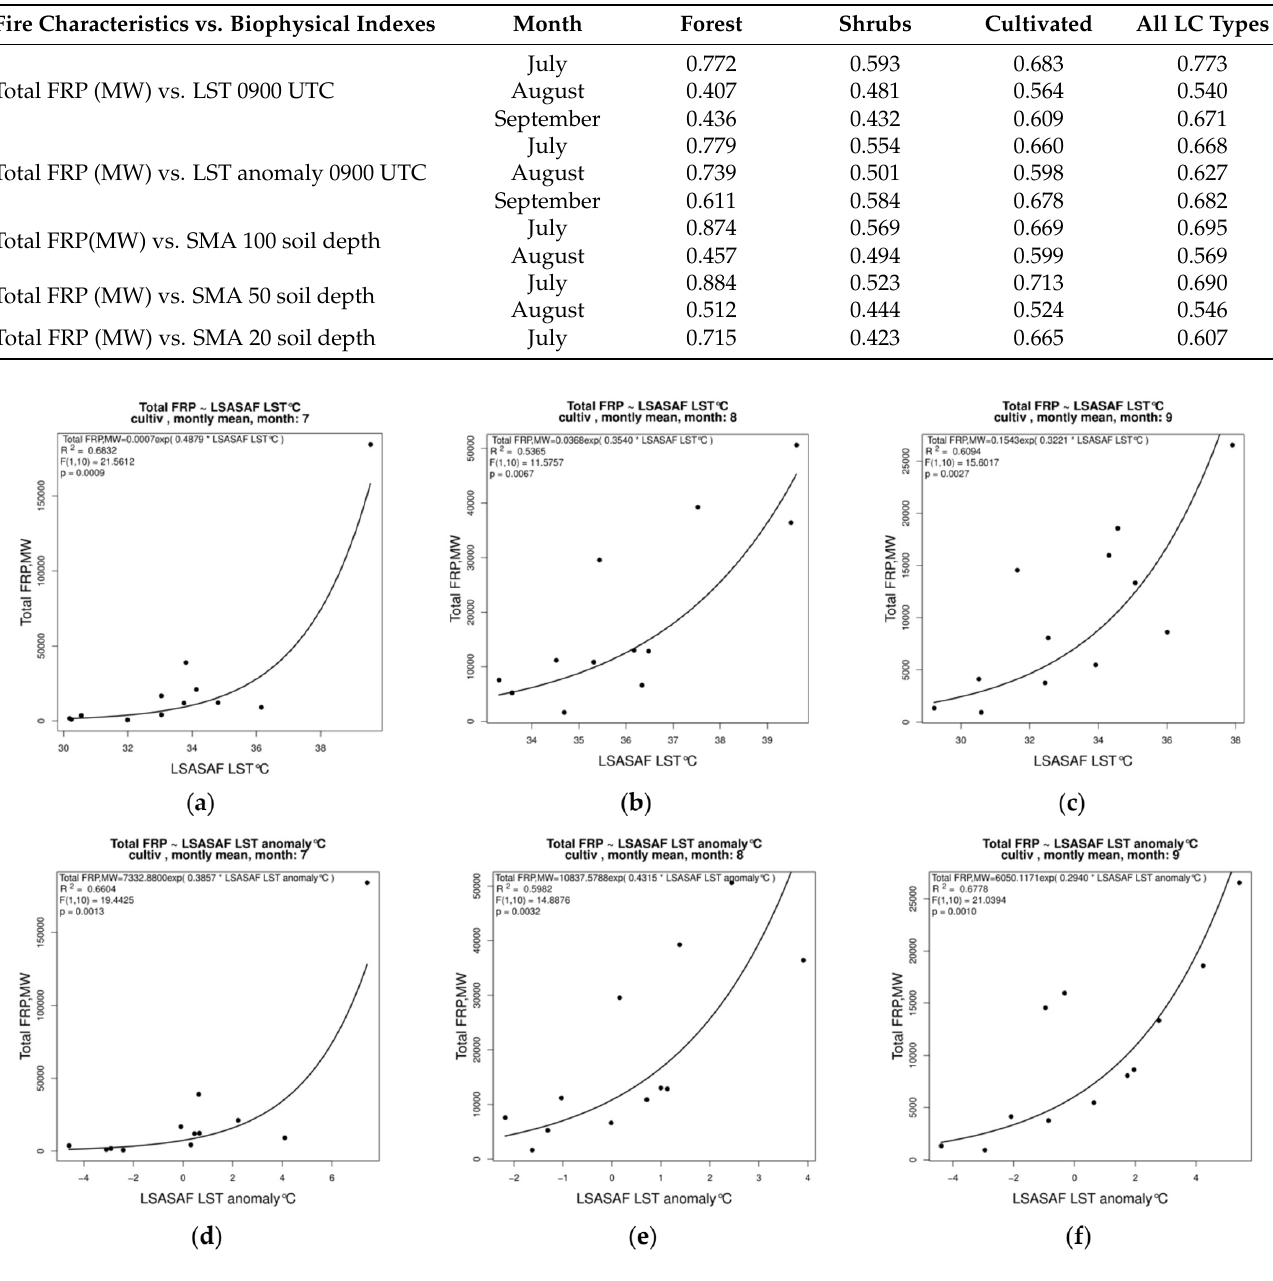
Figure 9. Regression models of the total energy released by biomass burning in Bulgaria according to the FRP-Pixel product, MW vs. LSASAF LST 0900 UTC for: ( a ) July; ( b ) August; ( c ) September, and vs. LSASAF LST anomaly (2007–2018) for: ( d ) July; ( e ) August; ( f ) September. Examples for cultivated land cover are